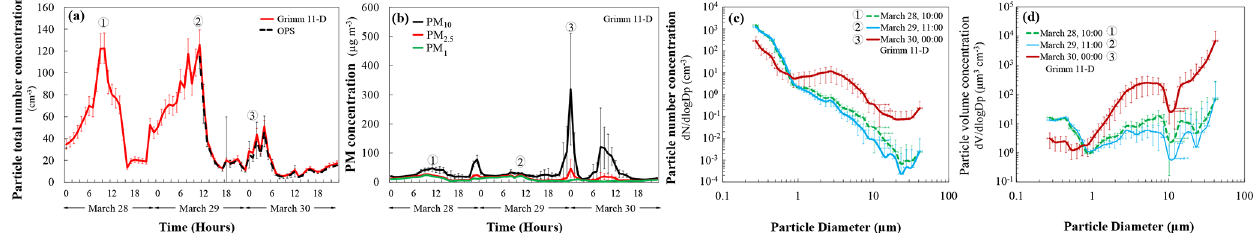
Figure 7. Measurements (hourly average) of total particle number concentration using OPS in black and Grimm 11-D in red (a) , measure- ments of PM mass concentration from Grimm 11-D (b) , and particle number size distribution (c) and volume size distribution (d) of optical diameter using Grimm 11-D for 28–30 March 2019. The numbers in the plots represent different events (1 and 2 for the haze events and 3 for the dust event). Error bars represent SD values of hourly